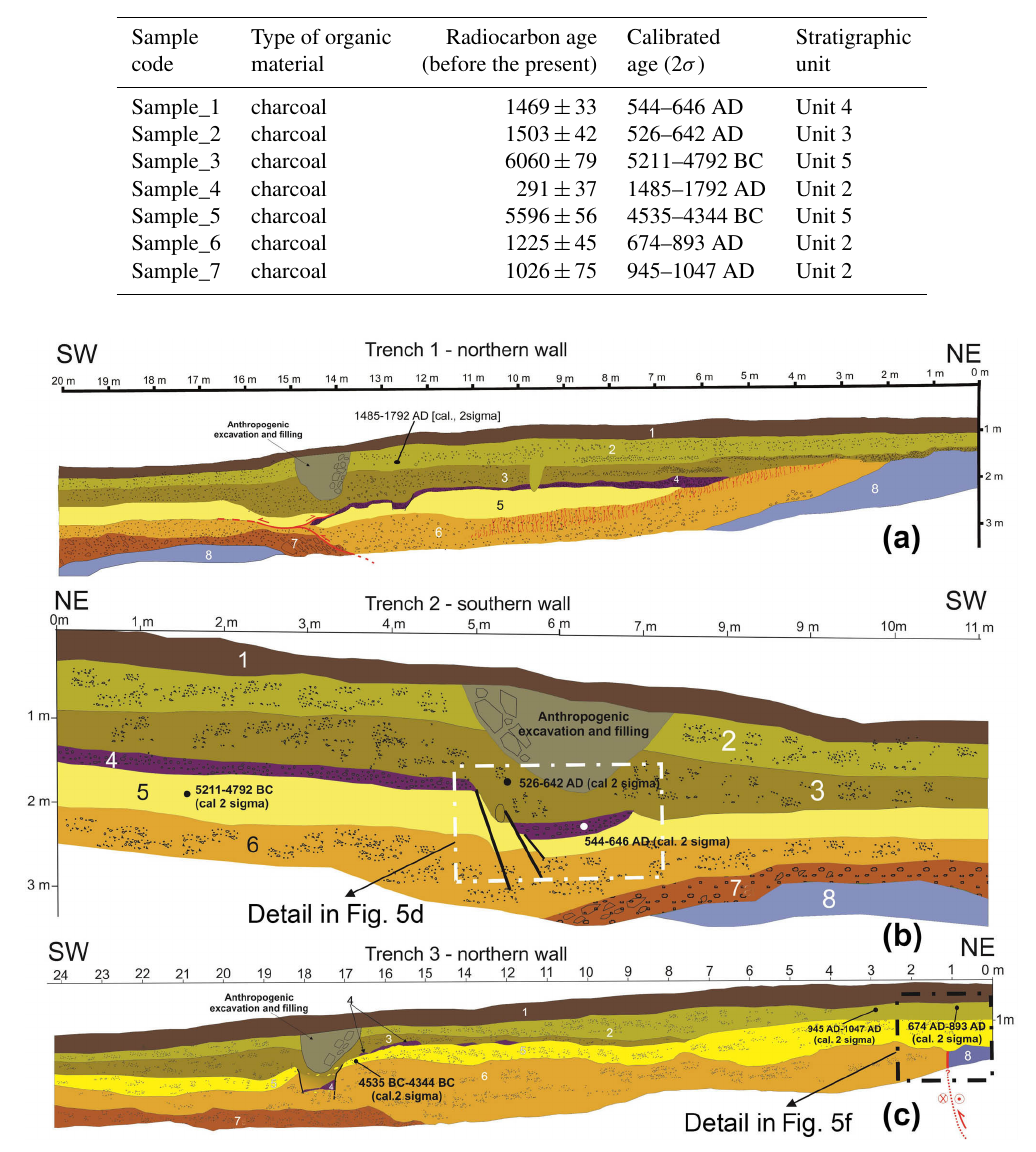
Table 1. Detail of the radiocarbon dating performed on the collected charcoals (calibration curve by Reimer et al., 2013).